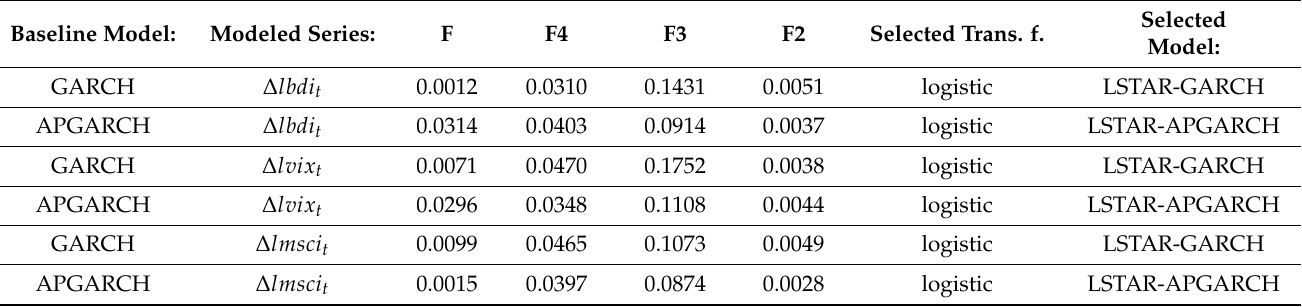
Table 5. STAR-type Nonlinearity and Model Architecture Selection Tests.